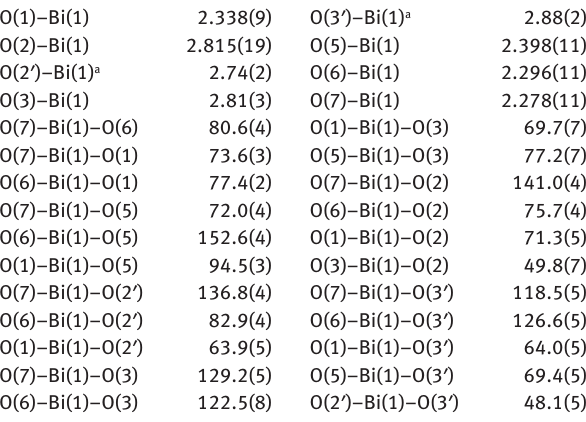
Figure 1 Molecular structure of [Bi(C )‧DMSO‧2H O. Symmetry transformations used: A = x, 0.5-y, z. (NO 3 2 Atomic positions of O2, O3, S1 and P1 are disordered (occupation factor of 0.5). C and H atoms are omitted for clarity.